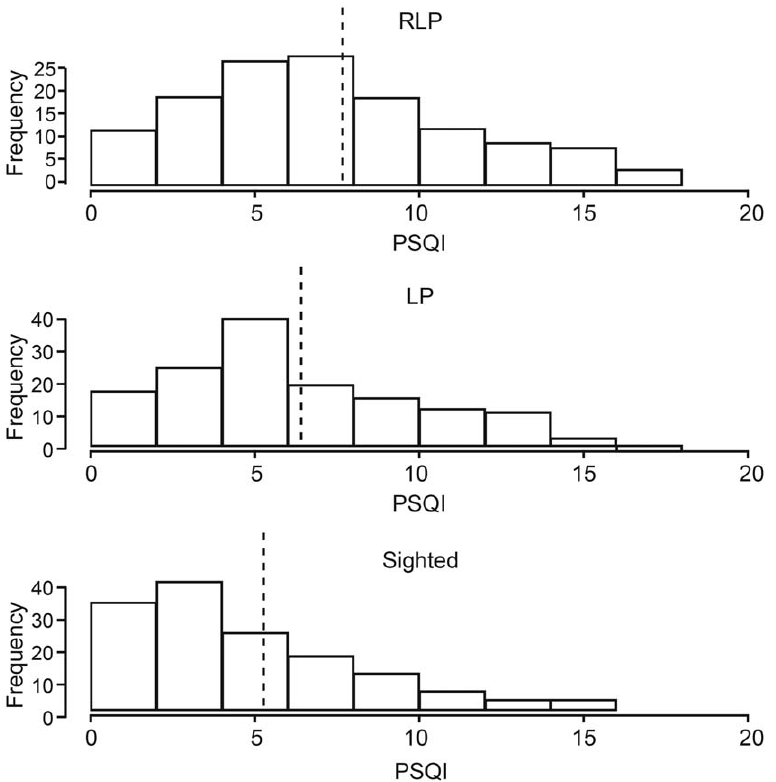
Figure 3. Distribution and frequencies of PSQI scores across the three subject groups. RLP – reduced light perception, LP – light perception in both eyes, FS – fully sighted. In each case, the mean PSQI score is indicated by a vertical dashed line.